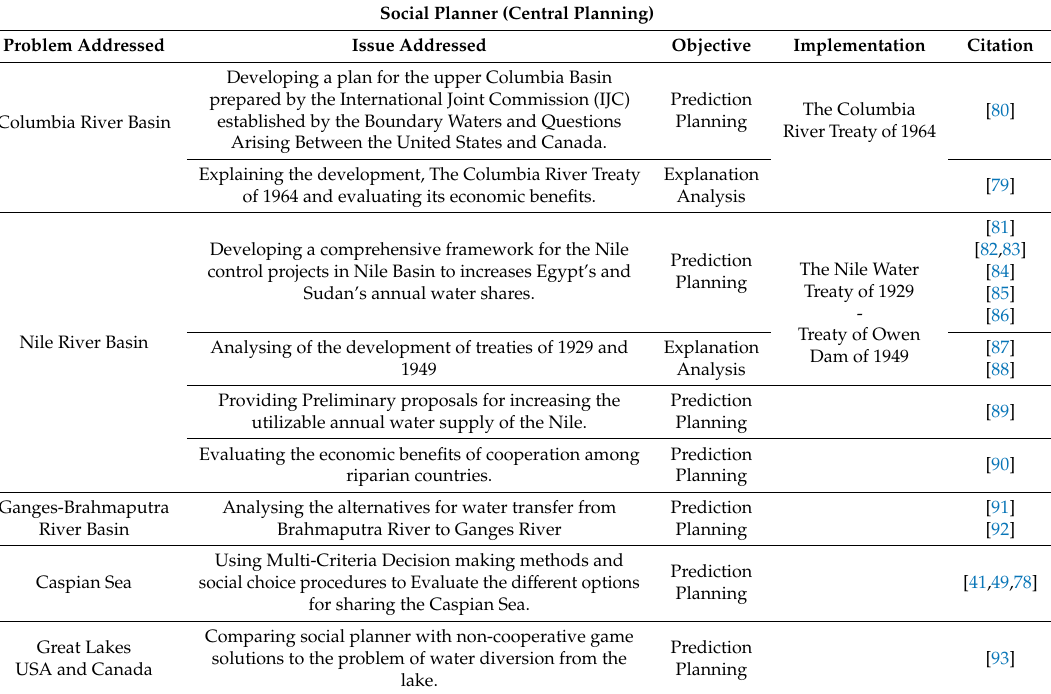
Table 3. Social Planner Mechanism—Theory and